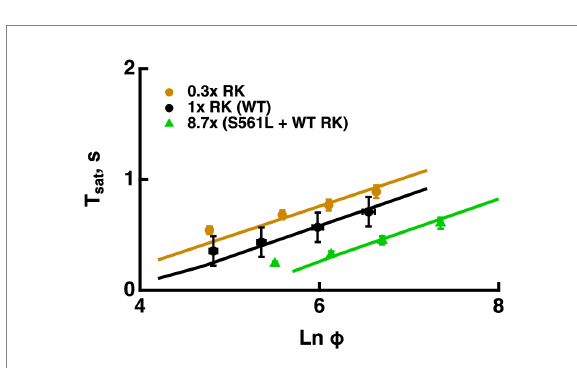
FIGURE 6 Changes in the rate of R * shutoff affected T sat without a change in τ D . Pepperberg plots for RK+/ − rods with lower than normal levels of RK (0.3x RK), WT (1x RK) and rods expressing an excess of mutant, S561L RK as well as WT RK yielding a total RK content that was 8.7-fold higher than normal (S561L RK + WT). For modeling, the phosphorylation rate of R* was decreased 3-fold for RK+/ − rods and increased 3-fold for S561L rods. T sat was measured from mid-flash to 10% recovery. Adapted from Gross et al.